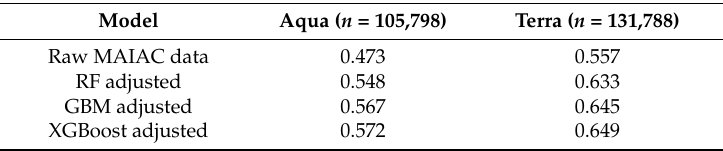
Table 3. Correlations between PM 2.5 and the predicted value of